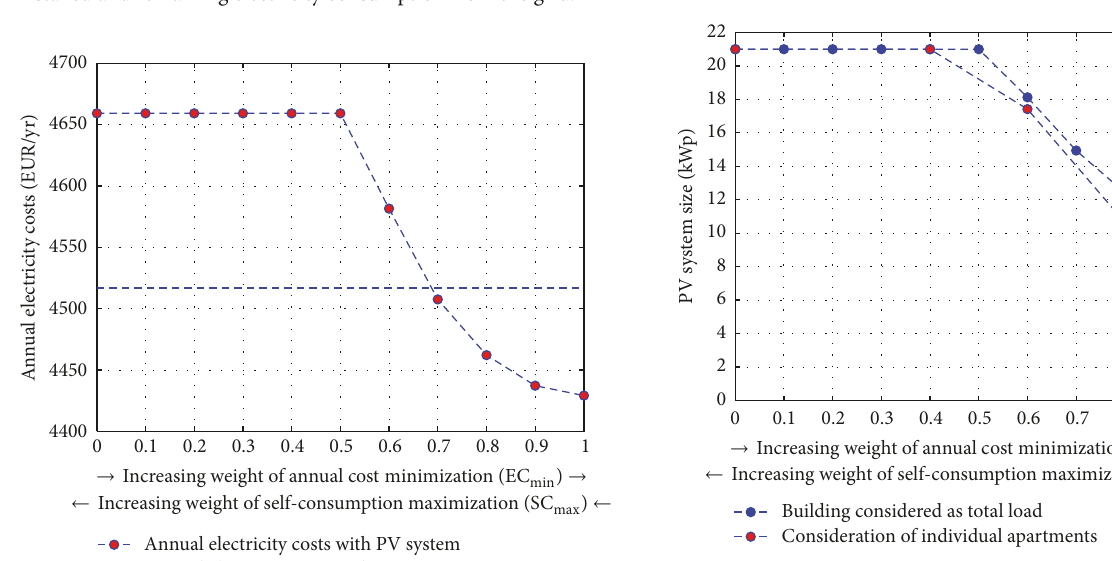
Figure 10: Austrianretail electricity prices: impact ofsynergy effects between load profiles on the optimal PV peak capacity